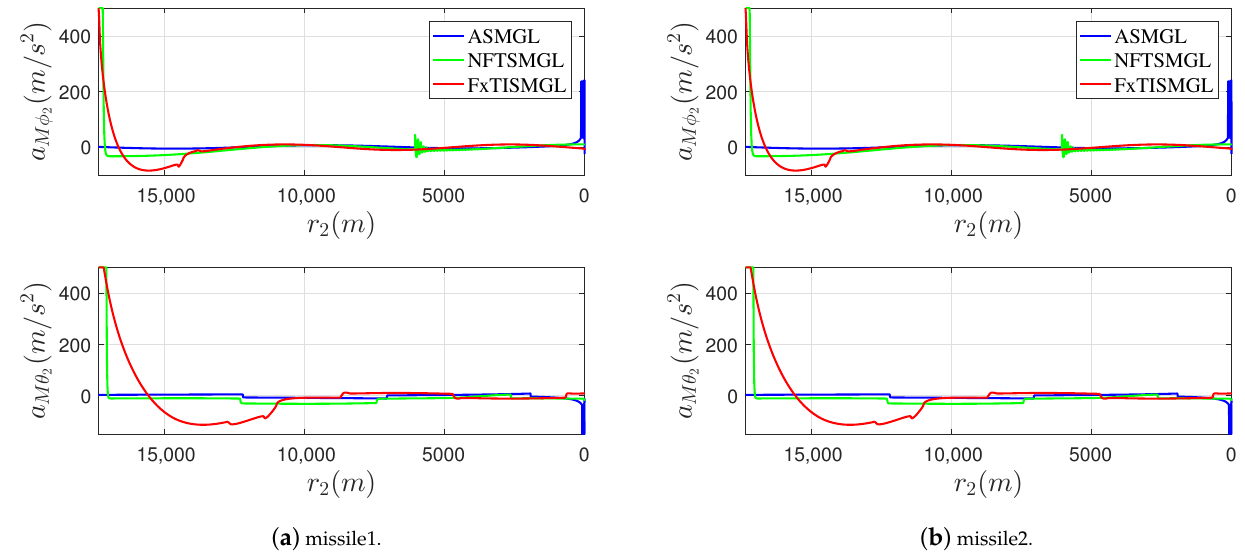
Figure 7. The curves of the acceleration